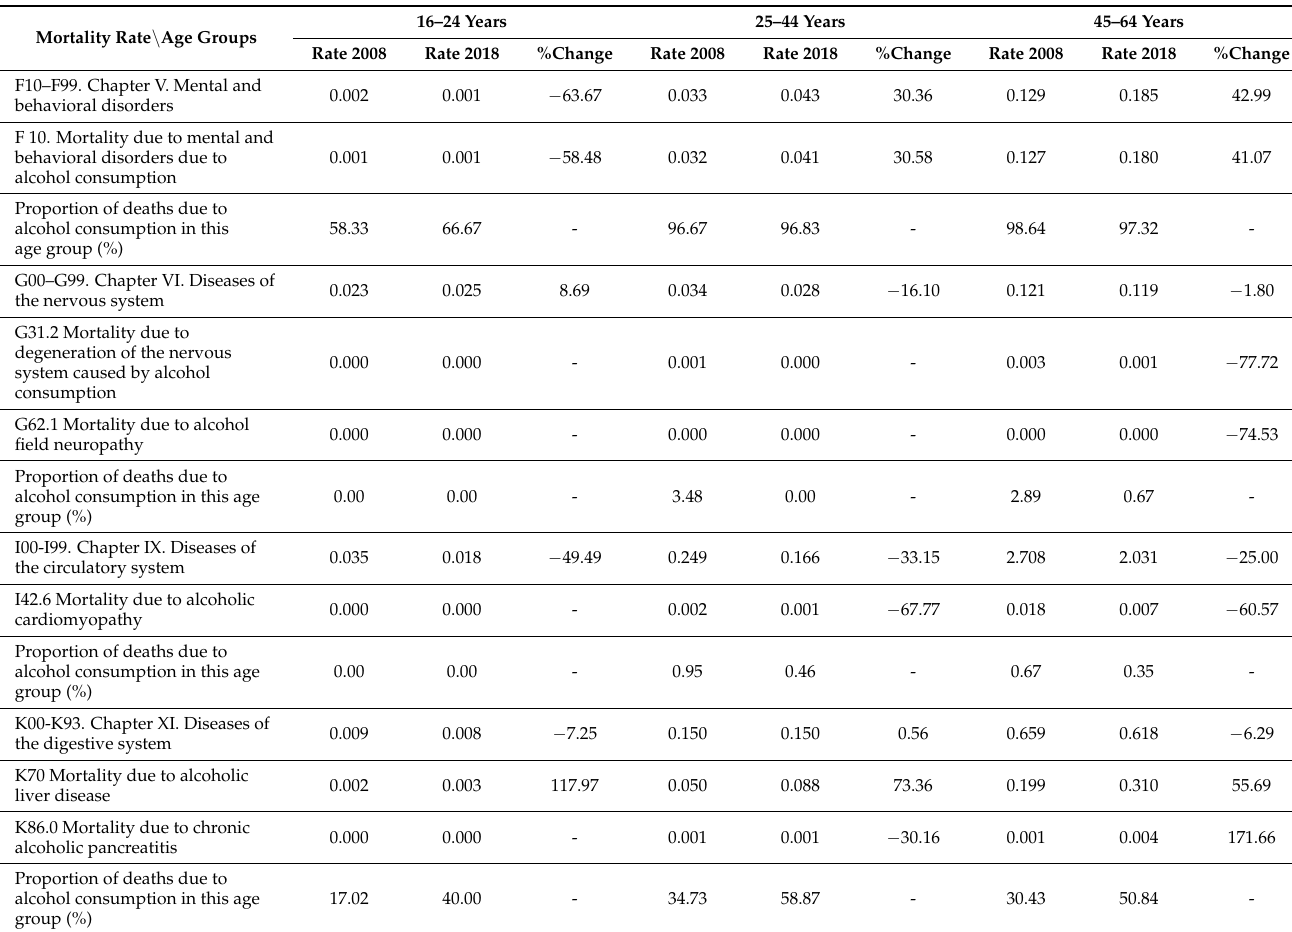
Table 7. Mortality of the working age population in Poland by causes of death and by age